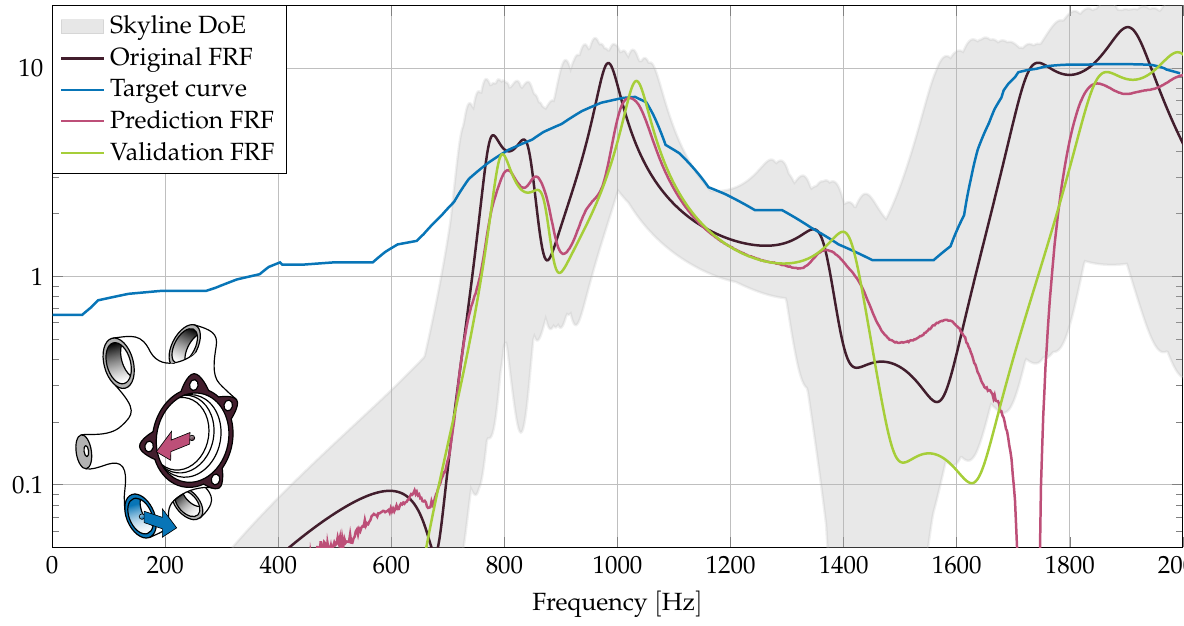
Figure 11. Optimization using a maximum-curve to achieve an eigenfrequency and amplitude reduction at multiple frequency